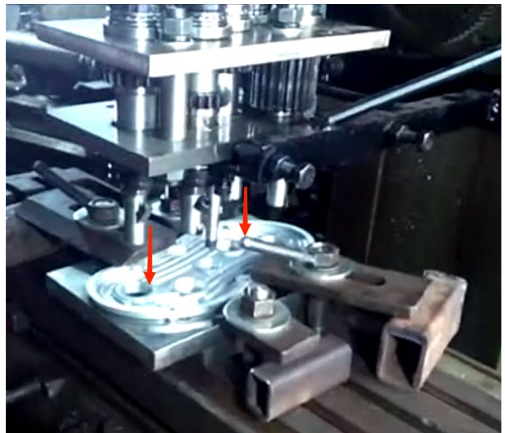
Figure 10. Gearbox processing